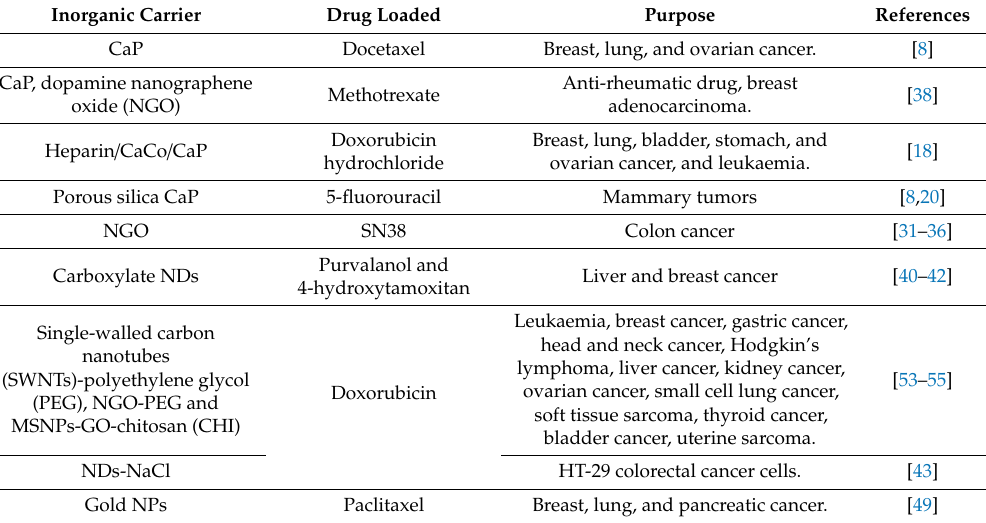
Table 1. Inorganic nanocarriers for drug